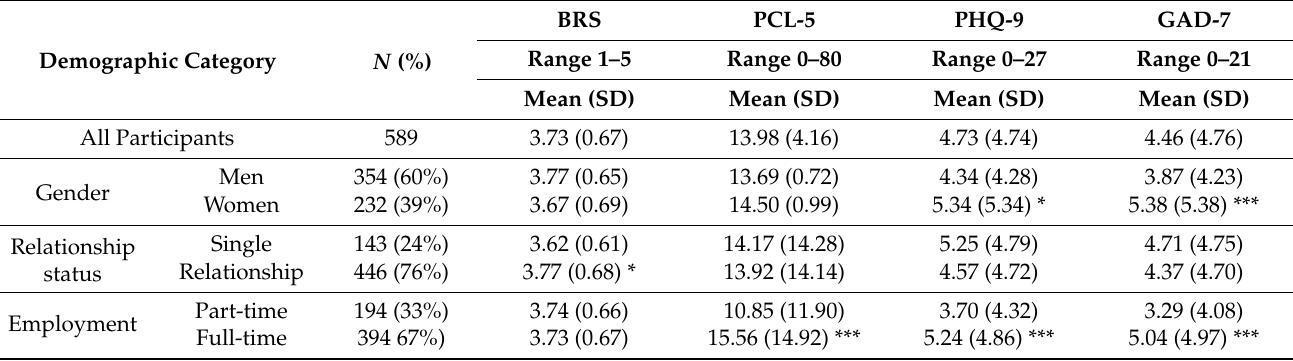
Table 1. Mental disorder symptom scores (mean score) stratified by demographic